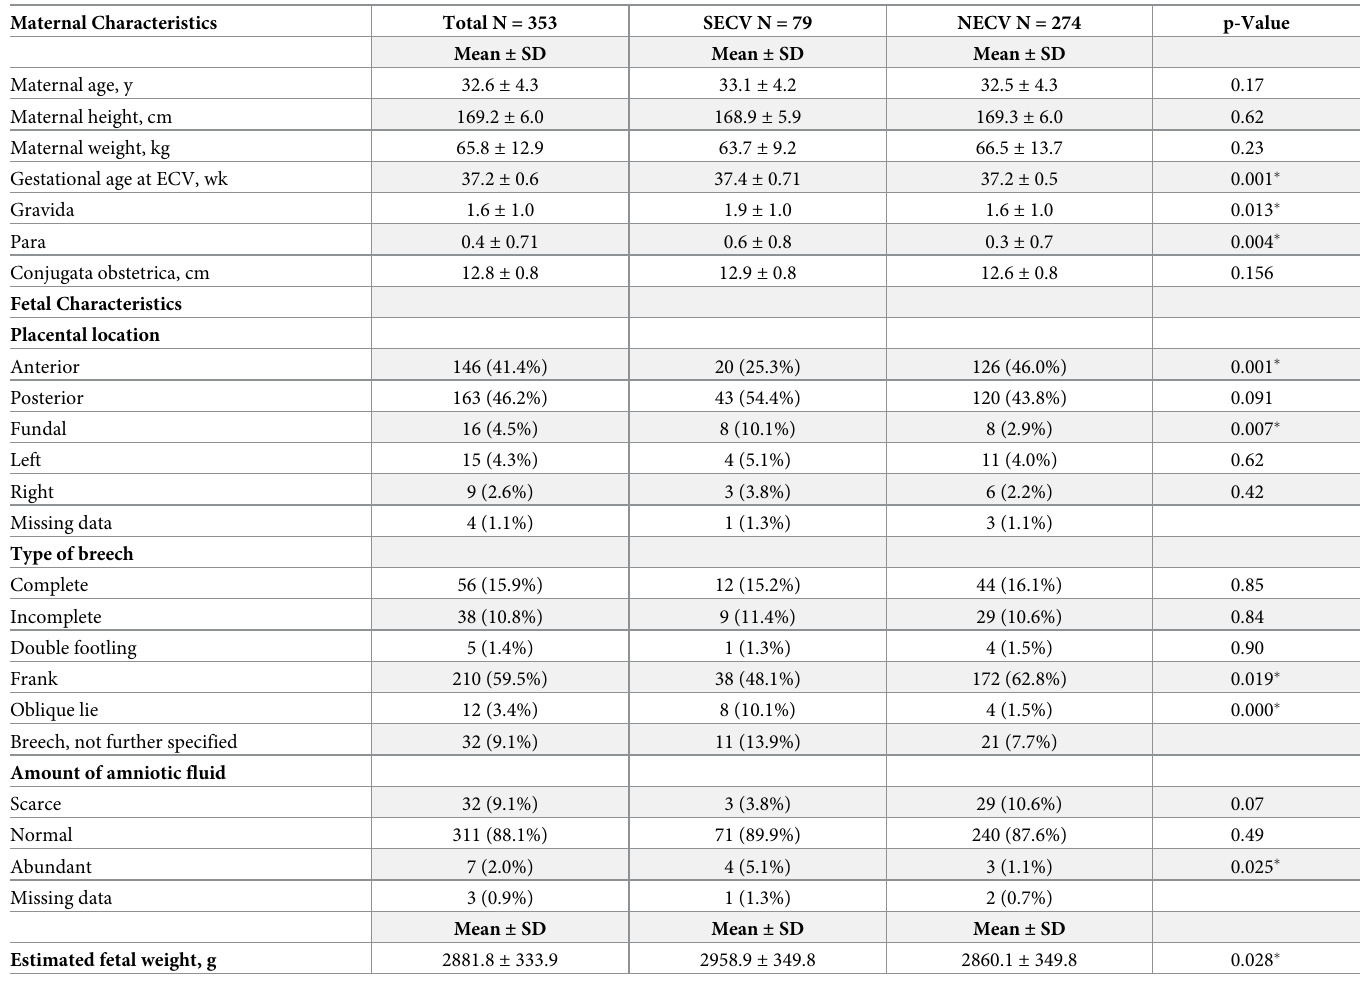
Table 1. Maternal and fetal characteristics.